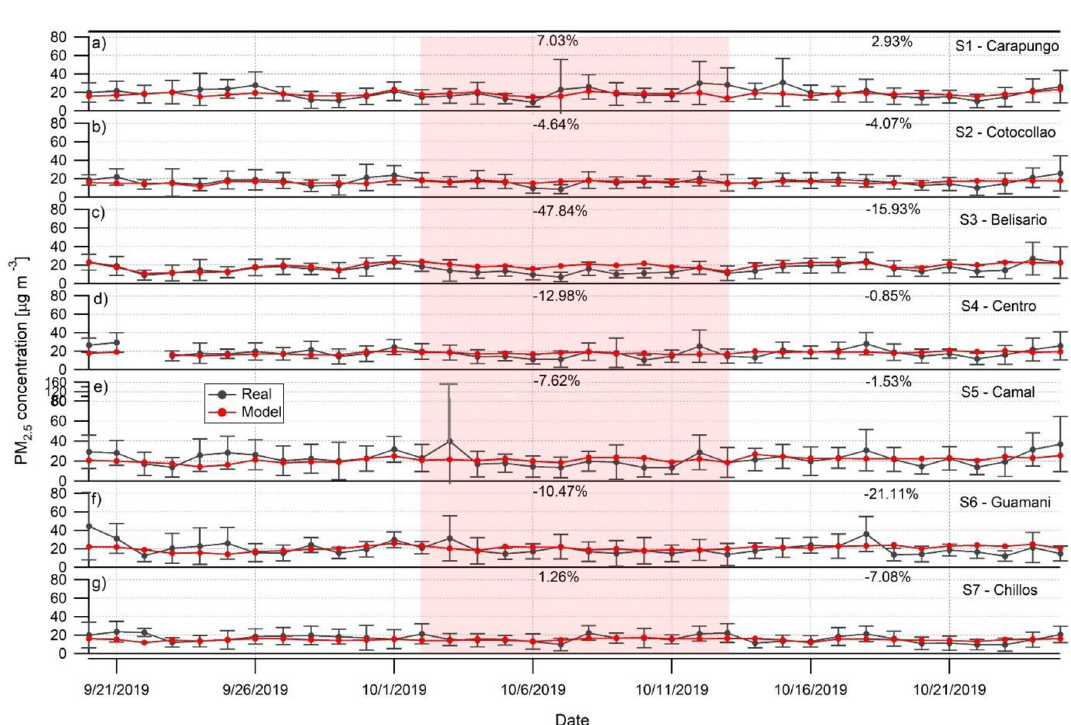
Figure 3. In black: daily averages and standard deviation (error bars) of PM 2.5 concentrations; in red: modeled values for PM the most northern to the most southern district: ( a ) S1 – Carapungo; ( b ) S2 – Cotocollao; ( c ) S3 – Belisario; ( d ) S4 – Centro; ( e ) S5 – Camal; ( f ) S6 – Guamani; and ( g ) S7 – Chillos. The percentage values identify change (negative = reduction, positive = increase) in PM 2.5 real concentrations from business-as-usual